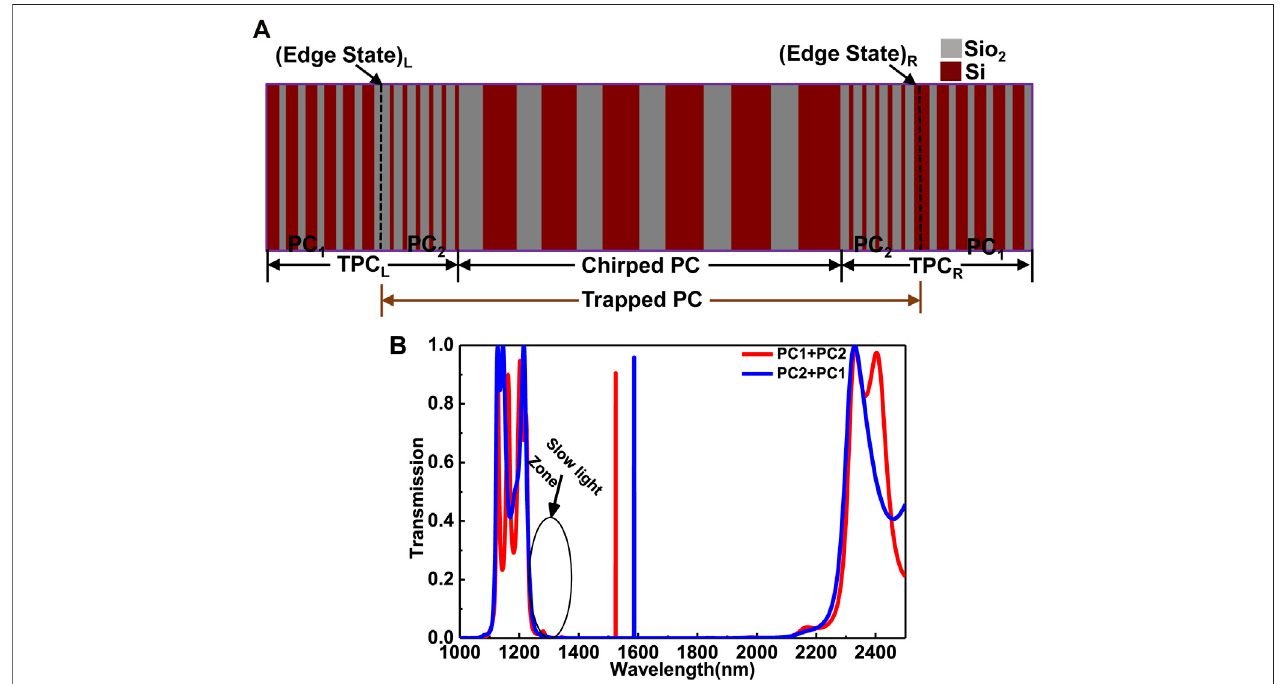
FIGURE 1 | (A) Schematic diagram of 1D PC heterostructure; (B) the transmission spectrum of TPC L andTPC R